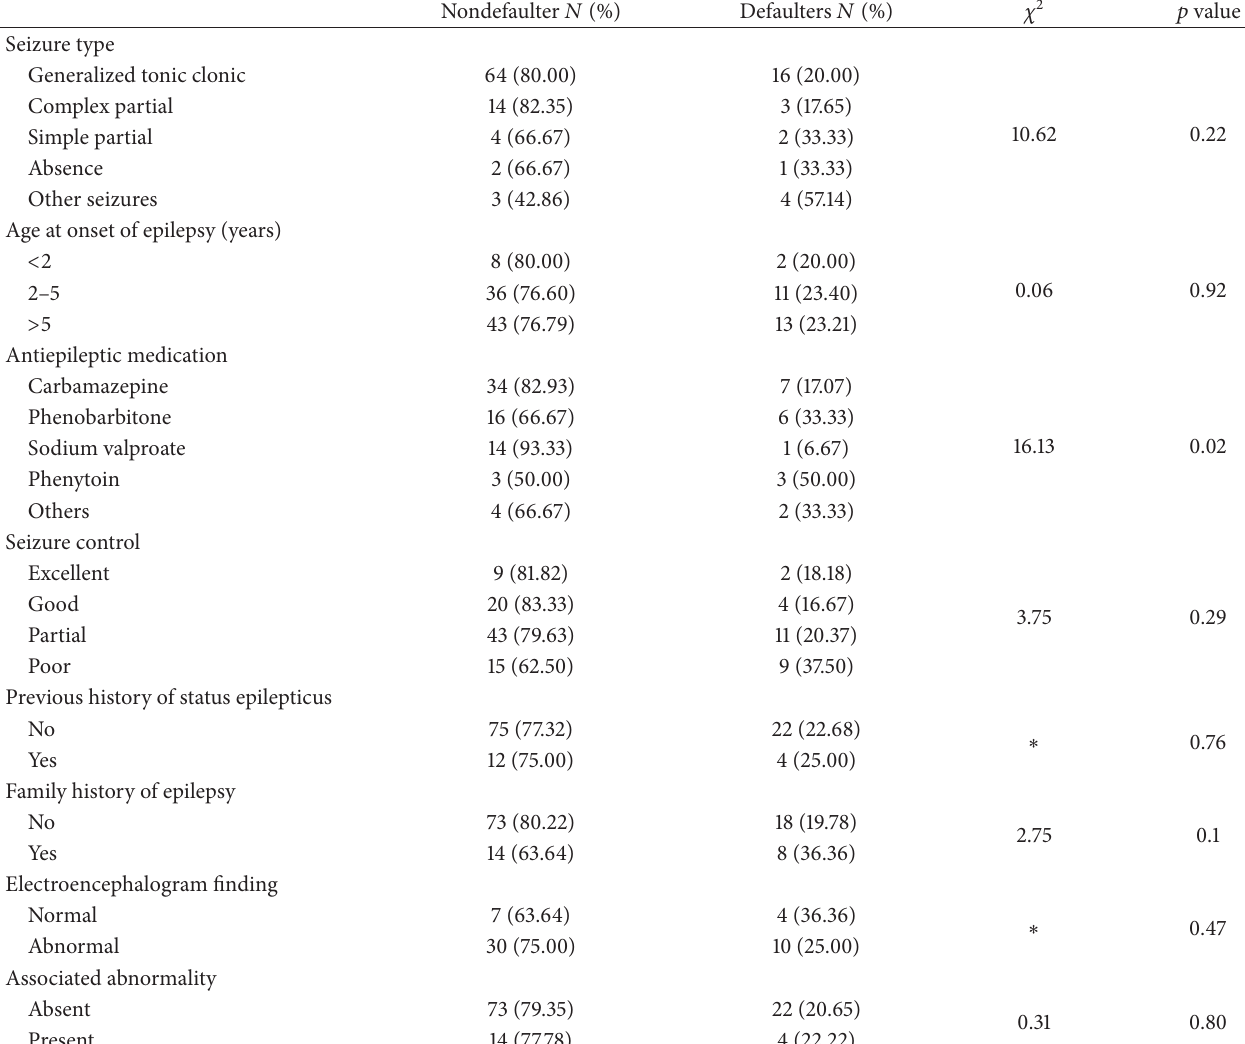
Table 2: The association between default from clinic appointments and seizure related variables.